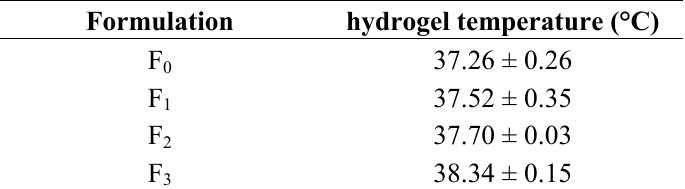
Table 1. The effect of NB/HP- β -CD concentration of inclusion complex on thermosensitive composite